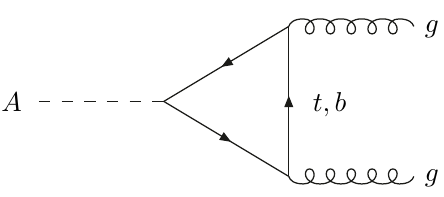
Figure 2 . Typical diagrams contributing to A → gg at lowest order.